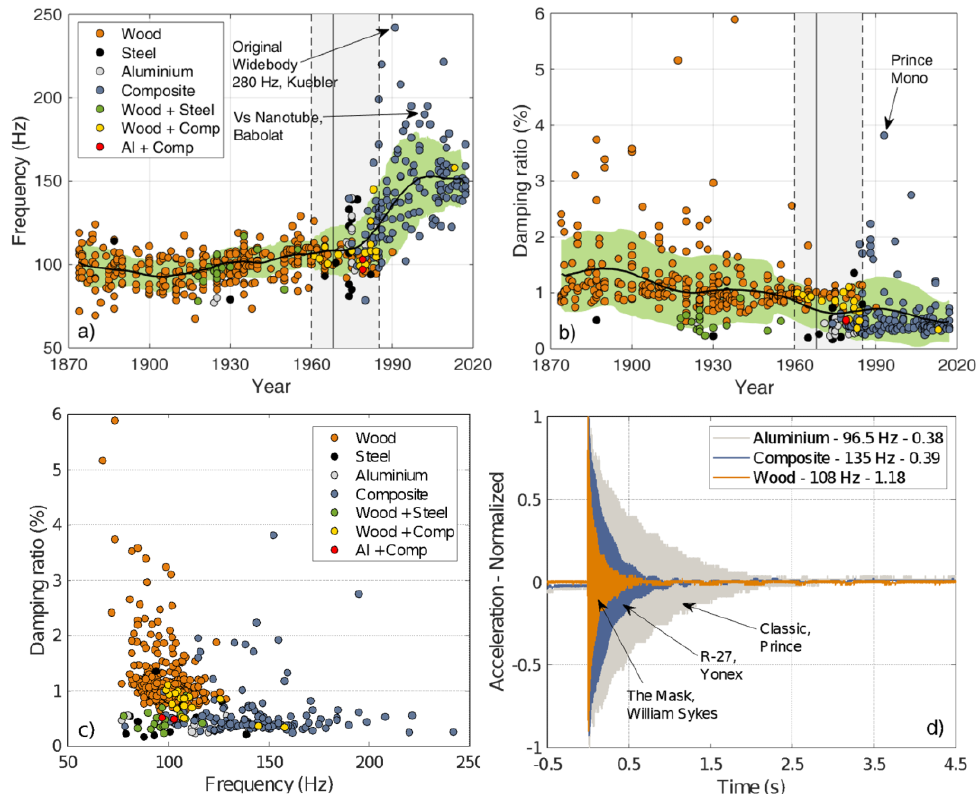
Figure 7. Dynamic properties of tennis rackets from the 1870s: ( a ) Natural frequencies; ( b ) damping coefficients; ( c ) natural frequencies vs.damping and ( d ) vibration signals in time domain (legend indicates natural frequency and damping coefficient).